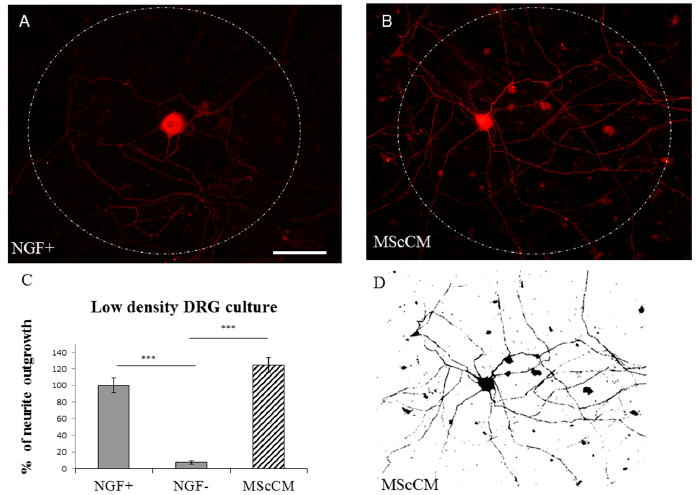
Figure 2. Neurite outgrowth of low-density plated PCDRGs, TUJ1 positive supplemented with: NGF ( A ); and MScCM ( B ). Quantification of neurite outgrowth. *** p < 0.001 indicates significant differences between groups ( C ). The image indicates TUJ1 stained cell with neurites after selecting the area to be analyzed and thresholding the number of pixels covered by the extending neuritis (Image J) ( D ). *** p < 0.001. Scale bars: ( A , B , D ) 50 μ m.